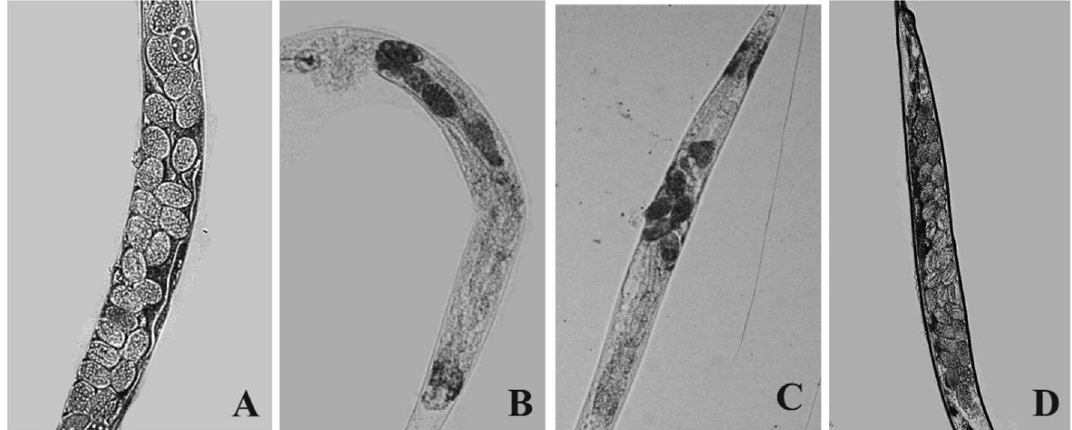
Figure 9. Microscopic images of the C. elegans exposed to Serratia marcescens for 24 h at 20 °C were presented. ( A ) Wild-type C. elegans fed with OP50 showed normal eggs with normal physiology. ( B ) In disparity, Serratia marcescens challenged nematodes exposed presented severe physiological defects such as distended pharynx and intestinal colonization ( C,D ) nematodes that was treated with quercetin showing reduced colonization and physiological damage compared to the control at ¼ MIC and ½ MIC